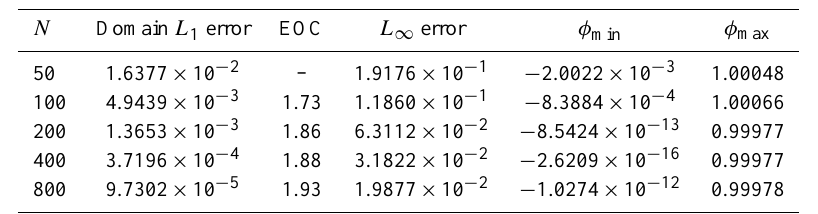
Table 5. Convergence study for the annulus advection test. L 1 error norm (full domain), experimental order of convergence (EOC), L ∞ error norm, minimum and maximum tracer values for different meshes.